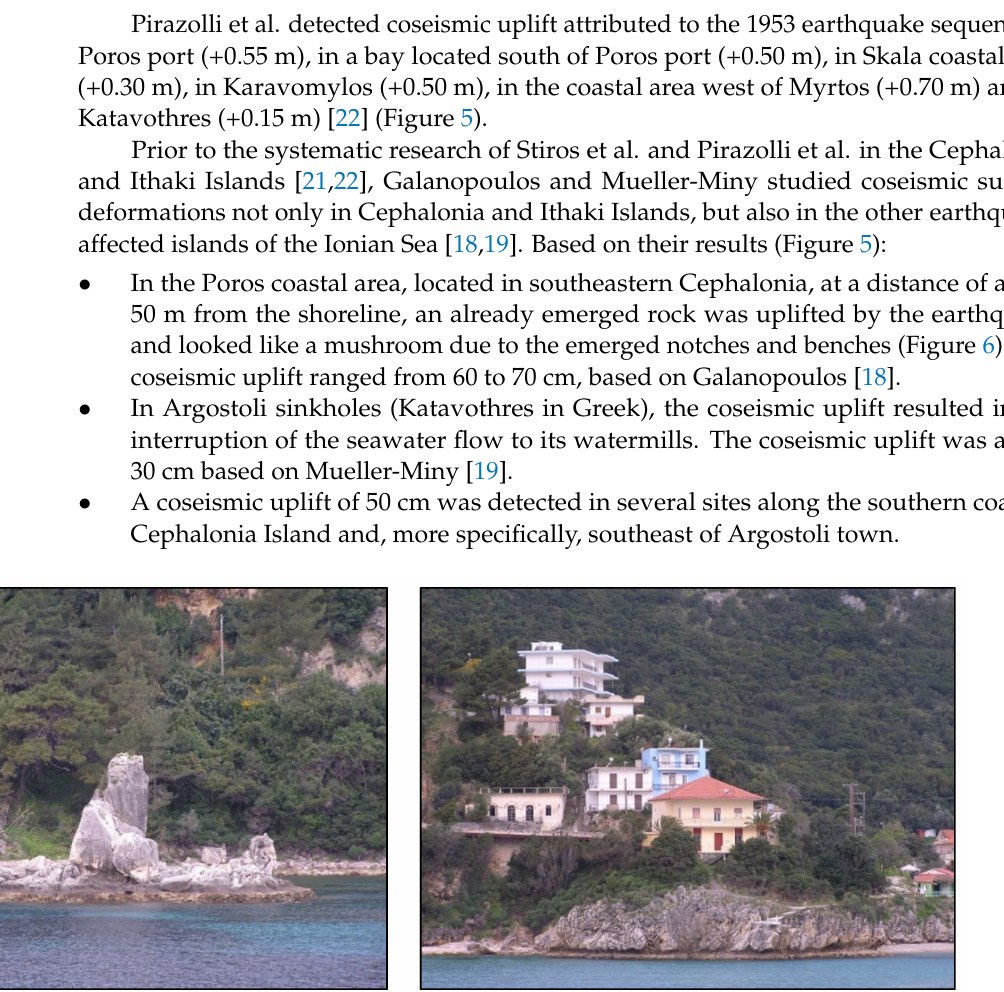
Figure 6. Notches in Poros coastal area located at southeastern Cephalonia emerged due to the August 1953 Ionian Sea sequence. The presented rocks were uplifted for 60–70 cm. The photographs were taken after the early 2014 Mw = 6.0 Cephalonia earthquakes (26 January and 3 February), which affected only the western part of the island, while its eastern part and these rocks remained